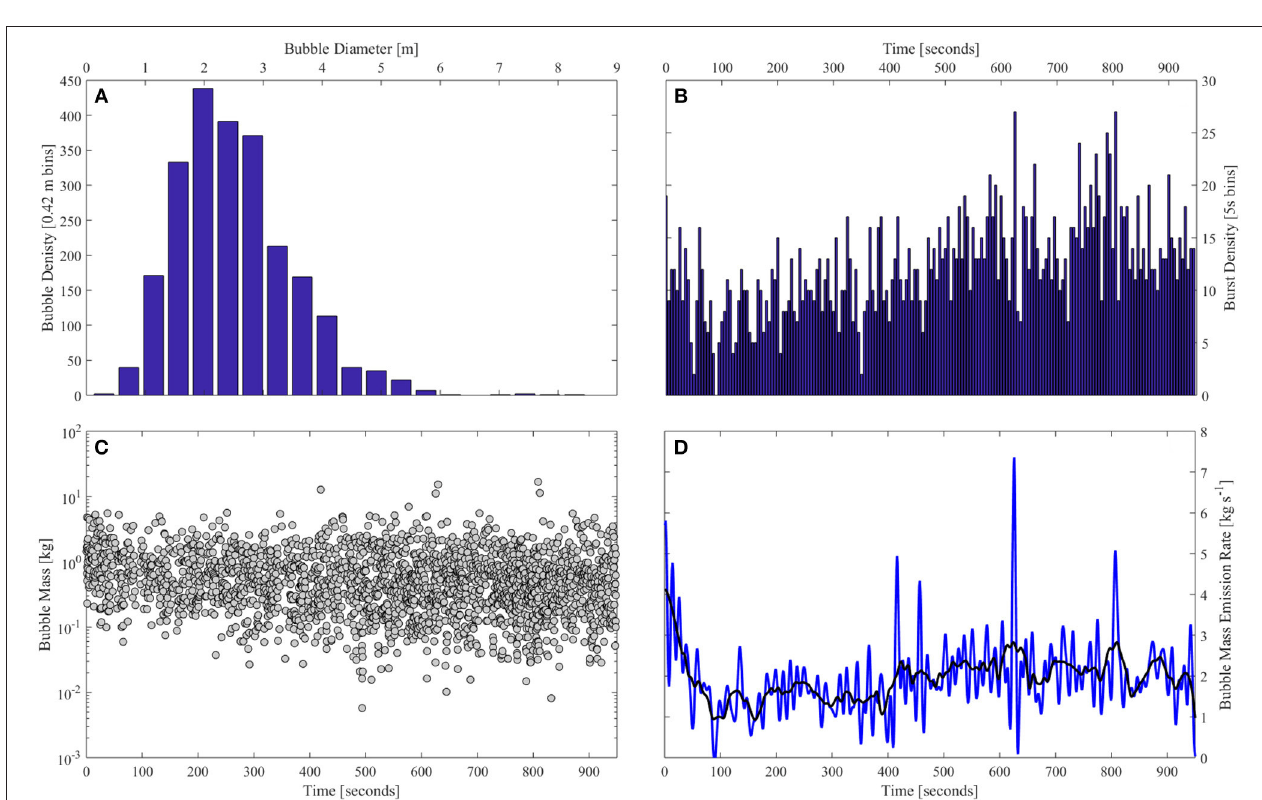
Frontiers in Earth Science |